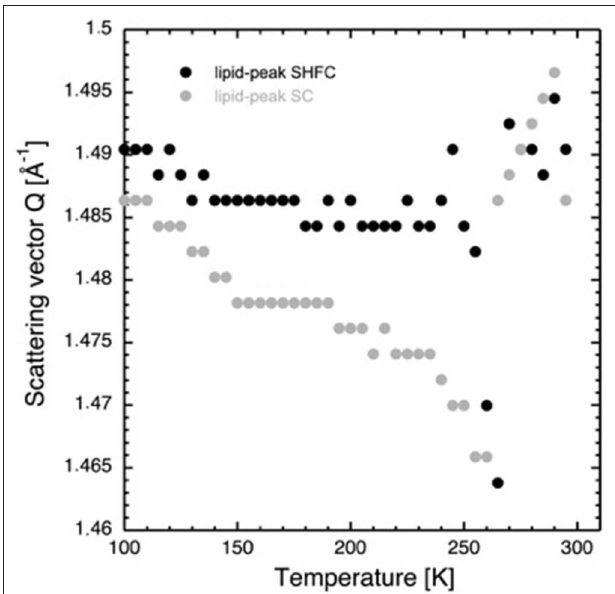
FIGURE 5 | Scattering vector Q of the lipid peak as a function of temperature during the SHFC protocol (black circles) and the subsequent SC protocol (gray